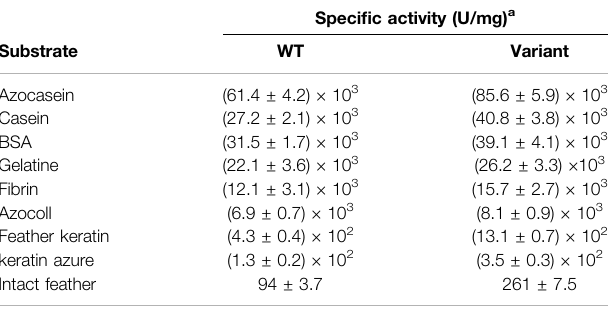
TABLE 1 | Speci fi c activities of wild-type (WT) enzyme and Y21pBpF/Y70pBpF/ Y114pBpF variant on different protein substrates.